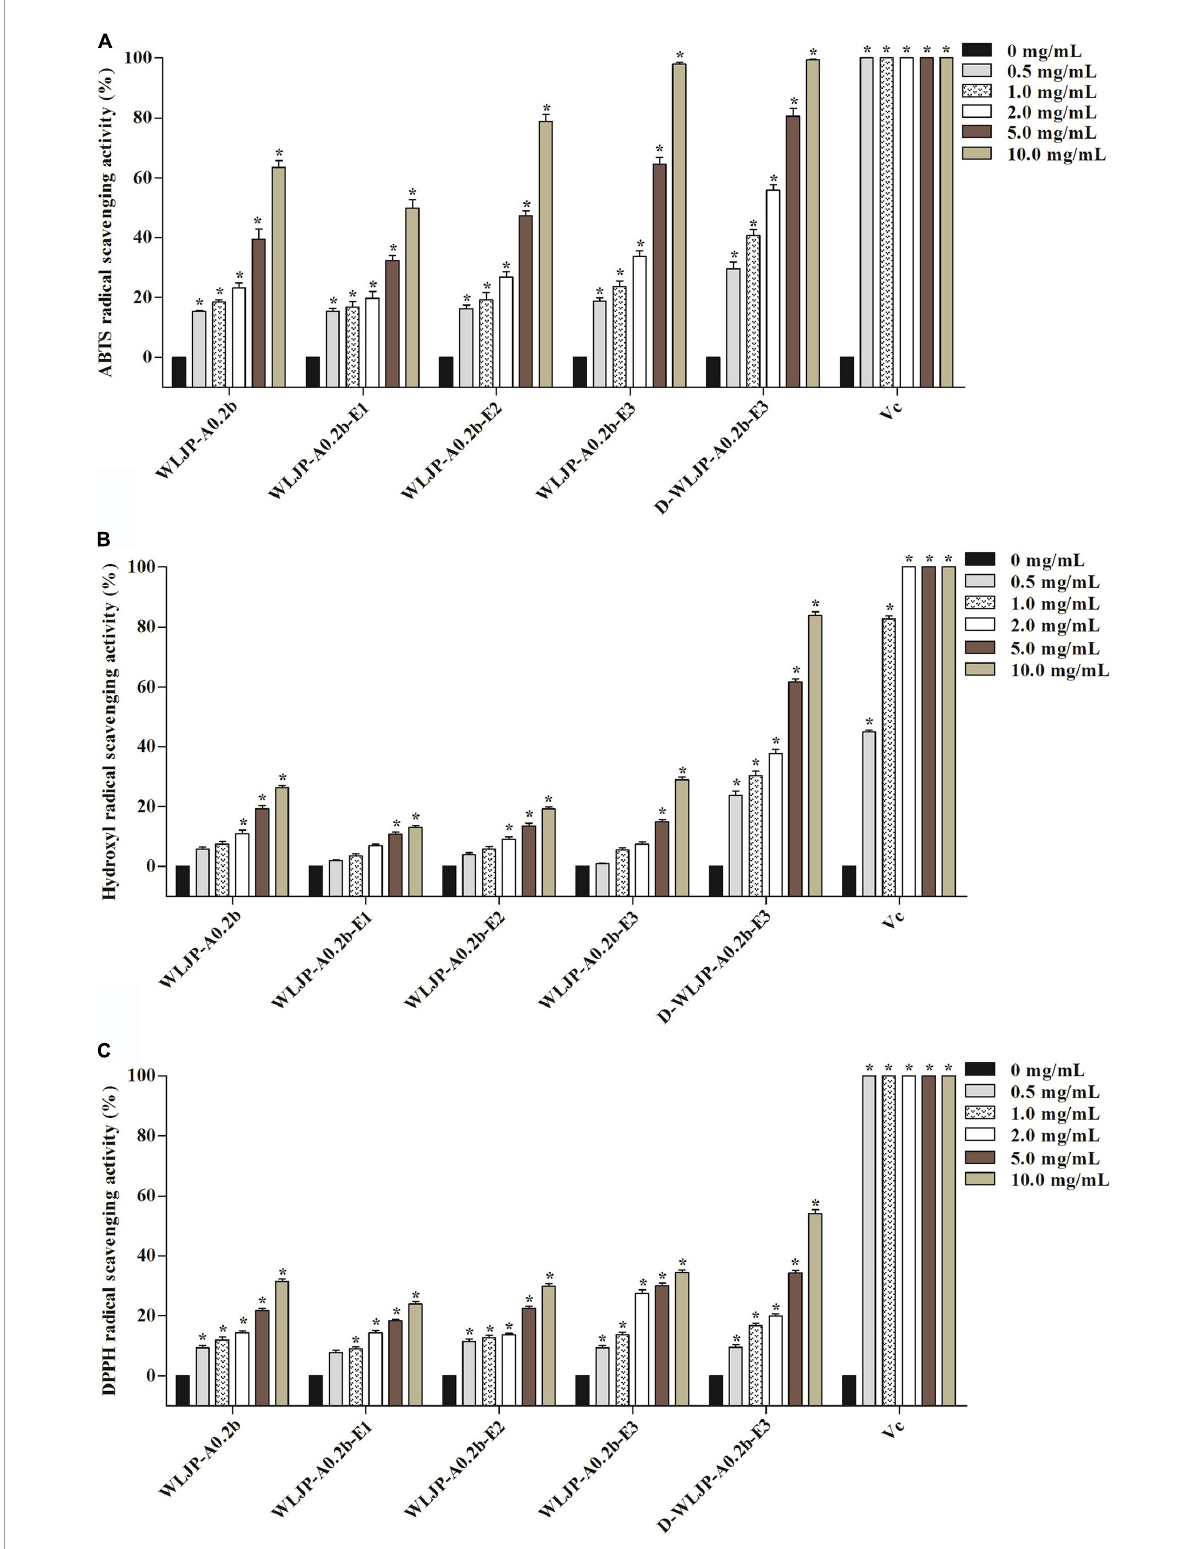
FIGURE6 Scavenging abilities of pectin from Lonicera japonica Thunb. on (A) ABTS radical, (B) hydroxyl radical, (C) DPPH radical. Vc was used as the positive control. Each value represented the mean ± SD ( n = 3, * p < 0.05). All experiments were performed in triplicate.